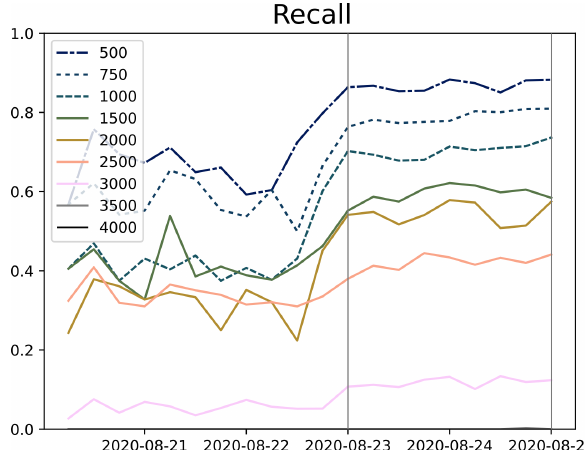
Figure 8. Recall over time for each flight altitude. Altitudes of 500 m, 750 m and 1000 m are presented as dash-dotted, dotted, and dashed, respectively, to aid visual separation. The recall for 4000 m is zero throughout the time series. The colours correspond to the colour bar and the two grey lines correspond to the two epochs shown in Figure